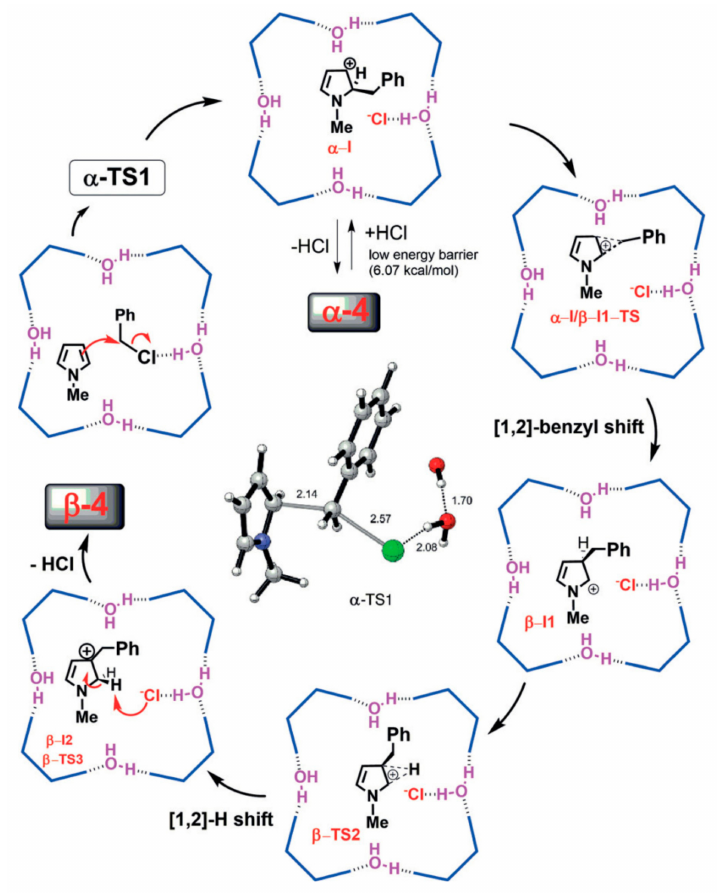
Figure 4. The mechanism proposed for the preferential formation of β -alkylation inside the capsule (Reproduced from Ref. [29], with permission of John Wiley and